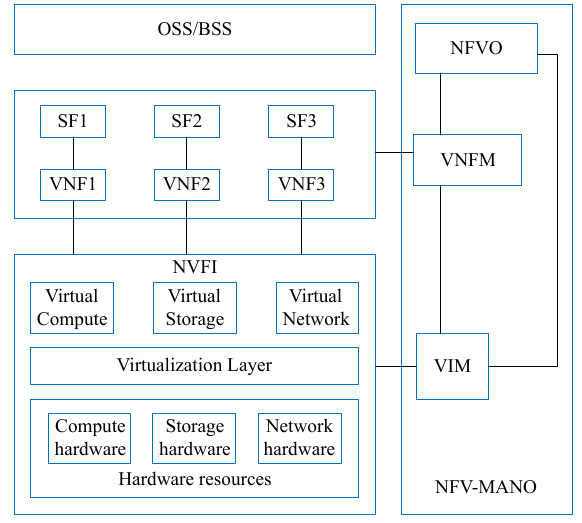
Figure 1. The ETSI NFV